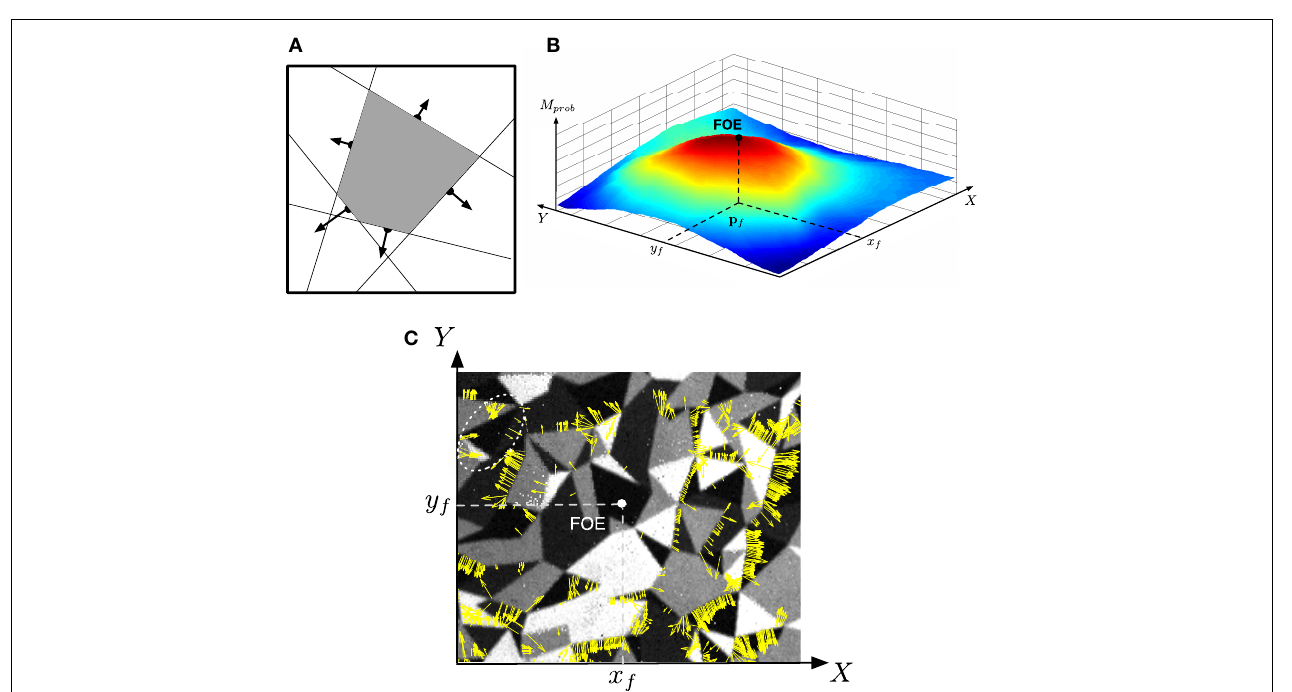
FIGURE 5 | Computation of the focus of expansion: (A) the focus of expansion lies under the normal flow, we can then vote for an area of the focal plane shown in (B) the FOE is the max of this area (C) Motion flow vectors obtained during a time period of (cid:3) t = 10ms and superimposed over a corresponding snapshot (realized using the PWM grayscale events; the viewed pattern is the same as used in Experiment